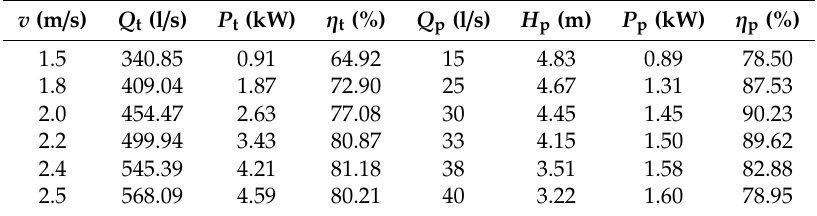
Table 3. Calculation on the external characteristics of the WTP at n = 350 r / min.